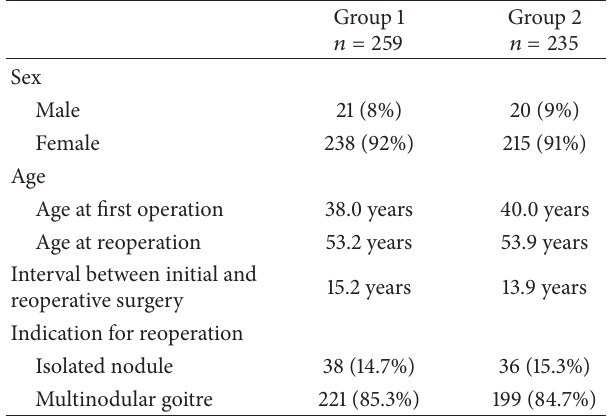
Table 1: Group demographics and timing and indication for reoper-